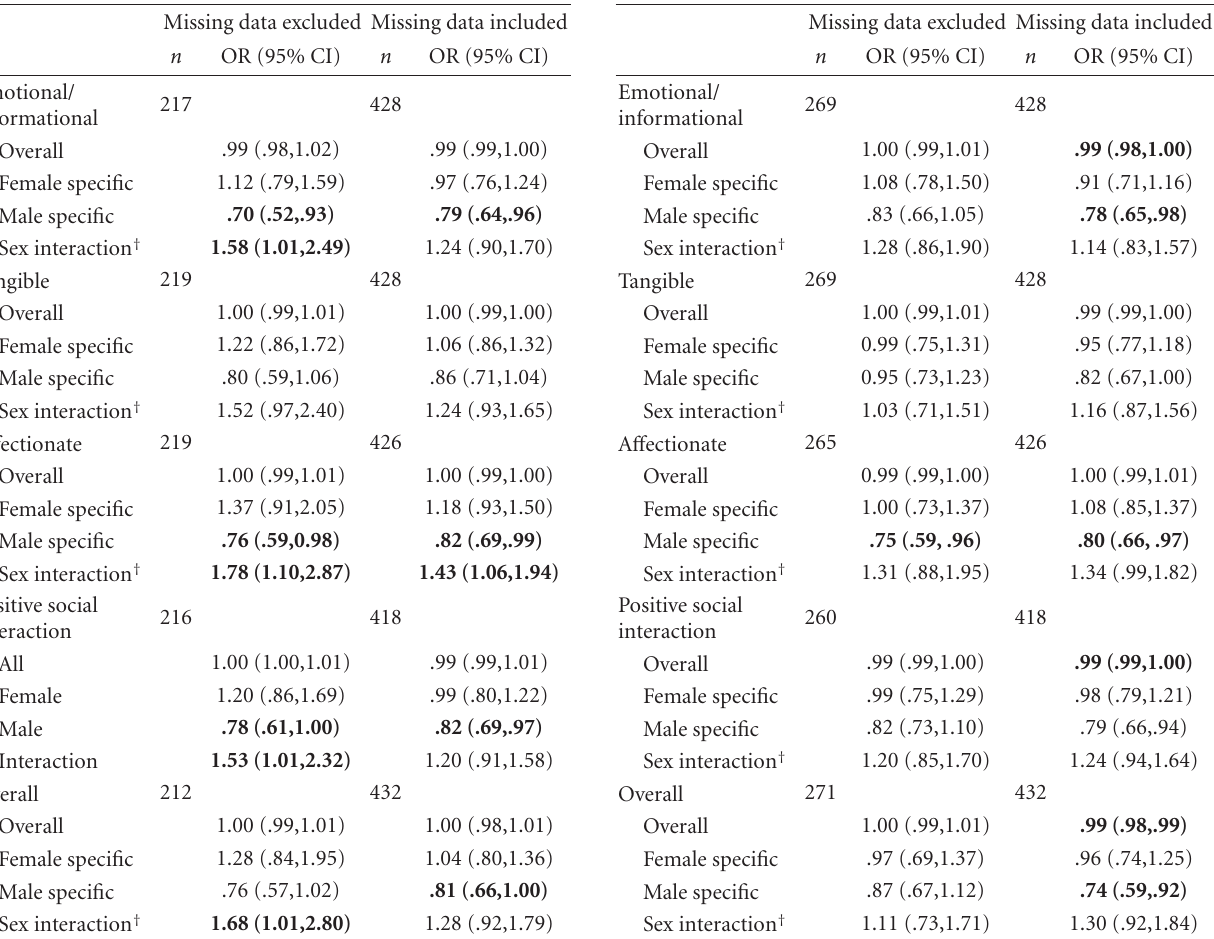
Table 5: Influence of social support on decline in SF-12-PCS. Table 6: Influence of social support on decline in KCCQ PL score.